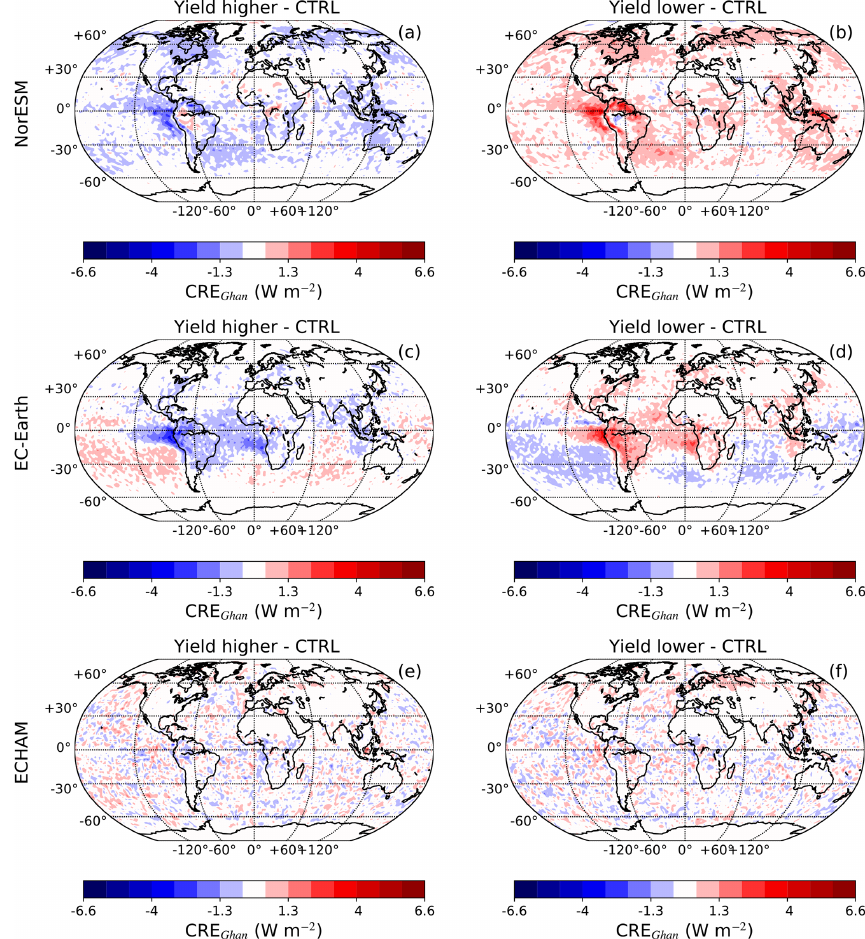
Figure 8. Maps of the difference in the average cloud radiative effect (CRE Ghan ) between the Yield higher (a, c, d) and Yield lower (b, d, h) with respect to the CTRL simulation. This is shown for NorESM (a, b) , EC-Earth (c, d) and ECHAM (e, f)